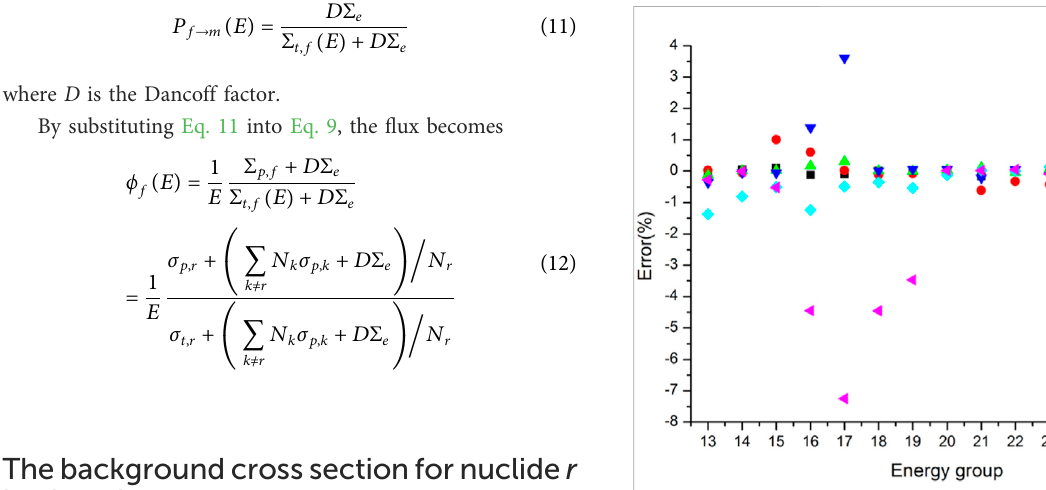
FIGURE 6 Comparison of resonant nuclides ’ absorption cross sections in 6 wt% PuO 2